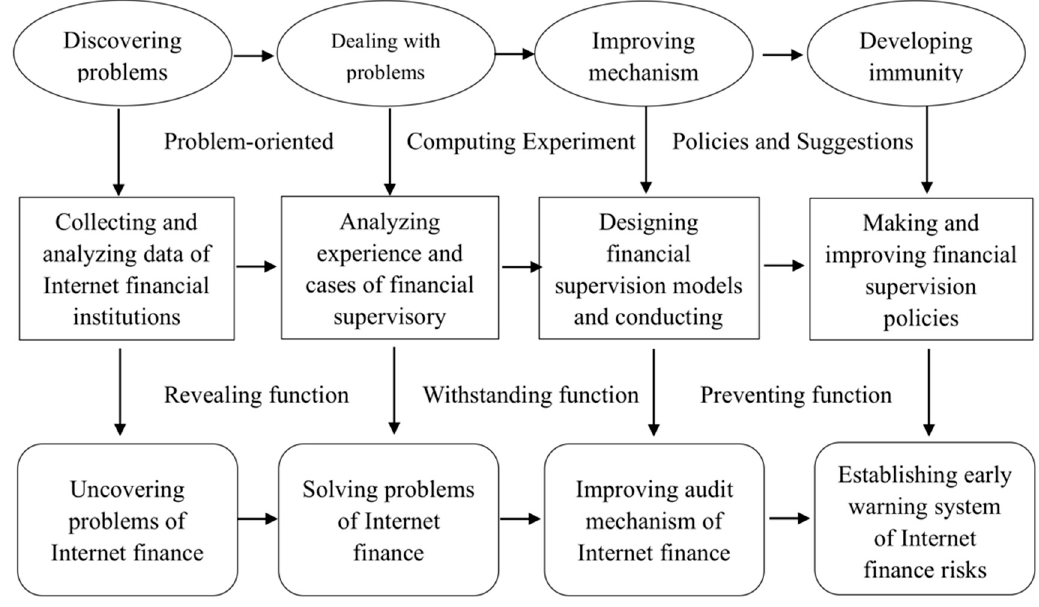
Figure 1. “Immune System” analysis framework of Internet finance government audit supervision.